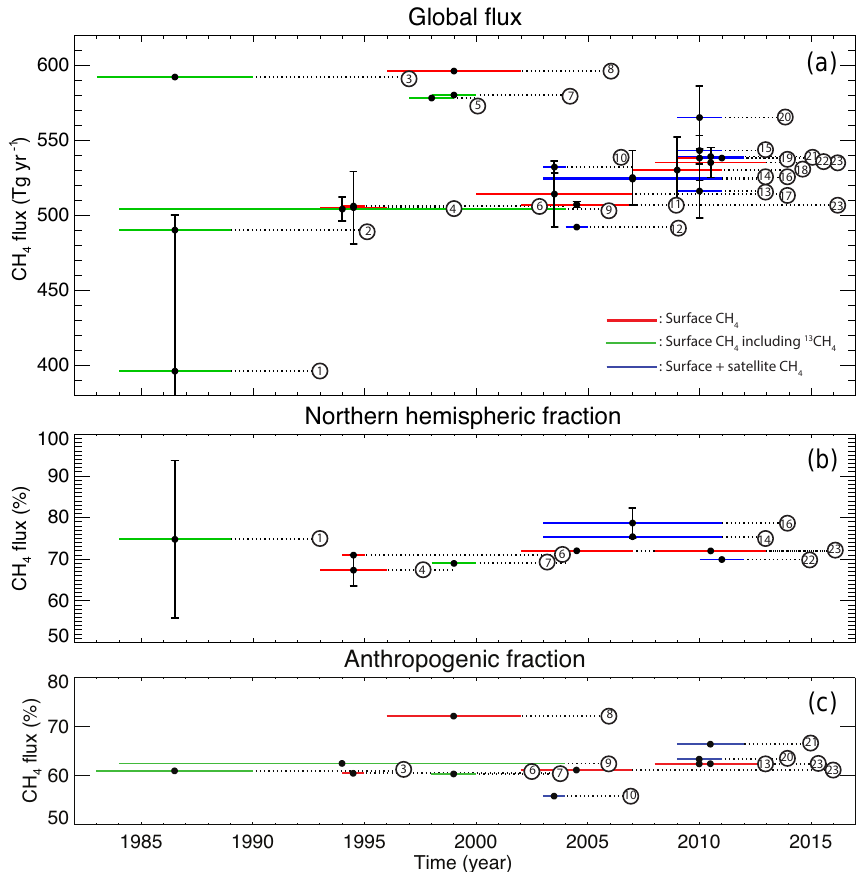
Figure 1. Evolution of inversion-derived estimates for the global total CH 4 flux (a) , its hemispheric distribution (b) , and the anthropogenic contribution (c) . Horizontal solid lines indicate the time range of the estimate. The right end of dotted lines point to the date of publication. Note that the CH 4 trends that are seen are influenced by the evolution of the inversion methods that were used. Numbered circles